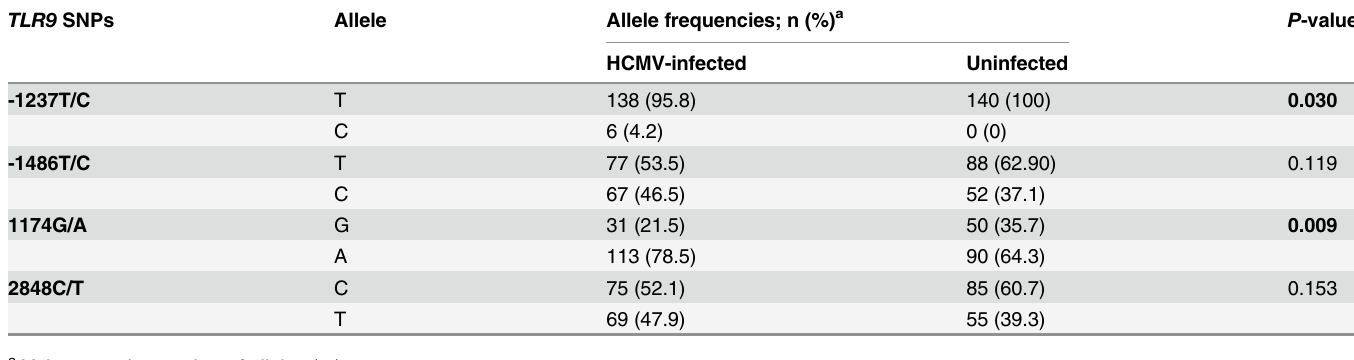
Table 5. The distribution of allele frequencies of TLR9 SNPs in infants with and without HCMV infection. TLR9 SNPs Allele Allele frequencies; n (%) a P